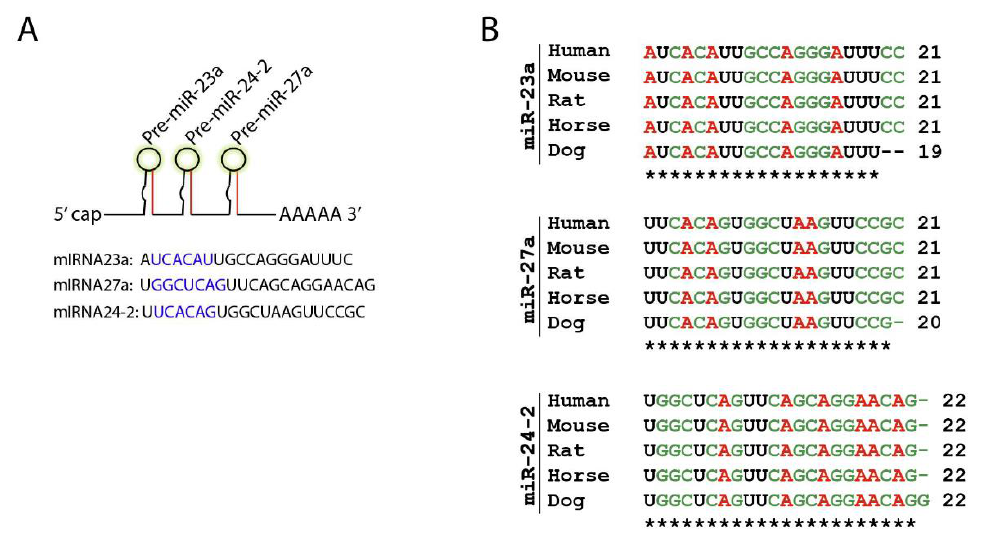
Figure 3. Mirc11 family is evolutionarily conserved. ( A ) Mirc11 cistron ( miRNA-23a cluster) is a tri-miRNA cluster. It consists of three members, miR-23a , miR-27a , and miR-24-2 , which are derived from a single primary mRNA transcript. The highlighted region forms the ‘seed sequences’ of these microRNAs. ( B ) Mirc11 cistron is highly conserved in mouse, rat, horse, dog, and human genomes. Mirc22 is a paralog of Mirc11 , which encodes miR-23b , miR-24-1 , and miR-27b located in mouse chromosome #13 (#9 in humans) [59]. Paralogs of miR-23 and miR-27 differ in one nucleotide, whereas the mature miR-24-1 and miR-24-2 are identical. Members of the Mirc11 ( miR-23a , miR-24-2 ) and Mirc22 ( miR-23b , miR-24-1 ) clusters are expressed at low